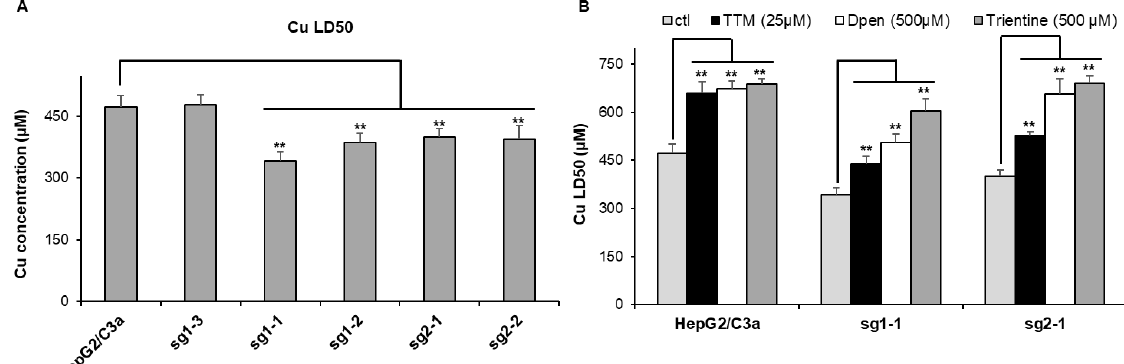
Figure 3. Sensitivity to Cu of the different cell lines. ( A ) Determination of the Cu LD50 for the HepG2/C3a cell line and for different clones isolated after the CrispR/Cas9 process. ( B ) Impact of various chelators on the lethality induced by Cu in the HepG2/C3a, sg1-1, and sg2-1 cell lines. The Cu LD50 was determined by MTT assay in the presence of the different compounds at the indicated concentrations. Data presented correspond to the average of at least three independent experiments +/ − standard deviation. ** stands for data statistically different from the control (ctl) or from the HepG2/C3a cell line with p < 0.01.